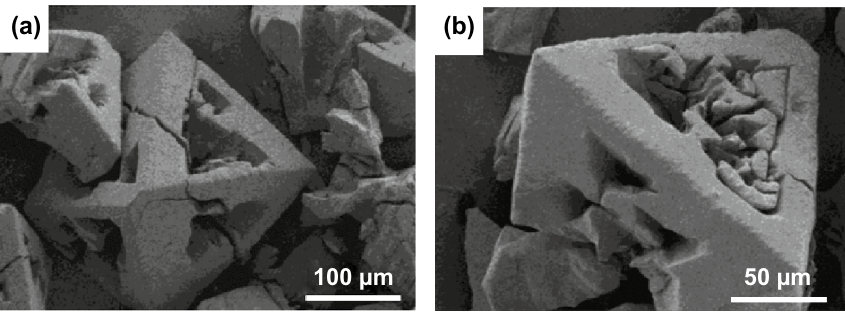
Fig. 12 SEM images of HKUST-1 particles modified by different reagents other than hydroquinone. a in 50 µL boric acid aqueous solution at 150 °C for 16 h and b in 50 µL NaCl aqueous solution at 150 °C for 16 h, showing some large etched holes were formed from the centre of the particles. Reprinted with permission from Ref. [95]. Copyright 2014 Royal Society of